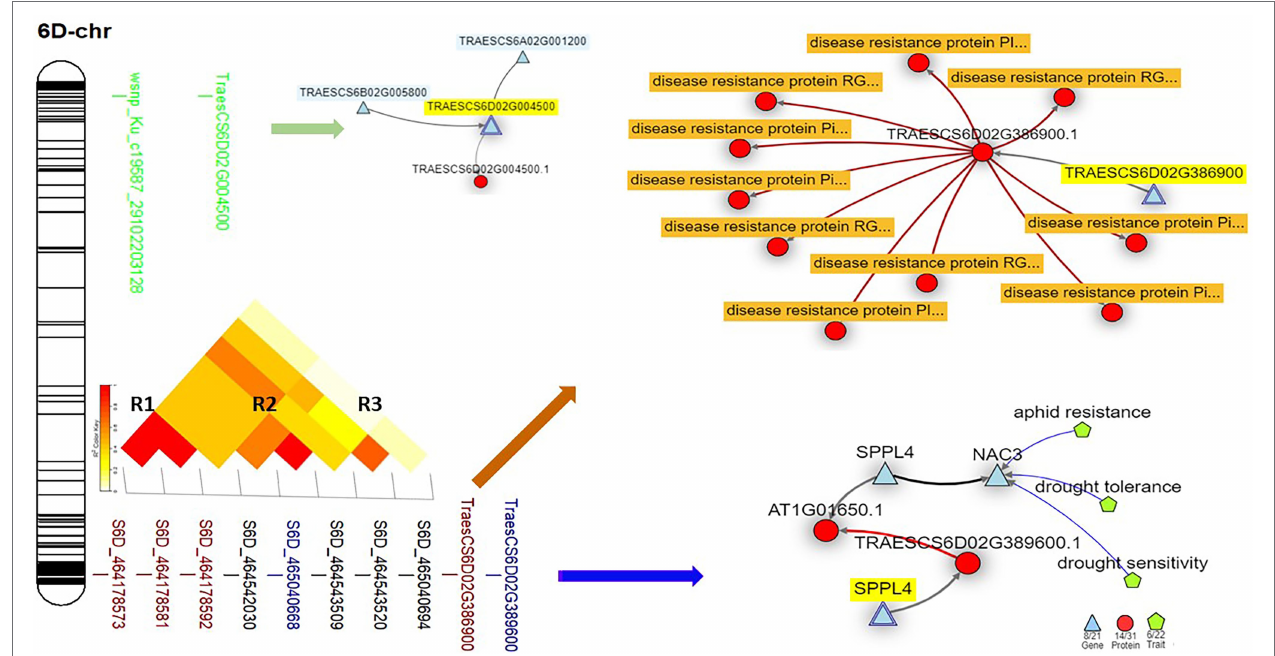
FIGURE 6 | The linkage disequilibrium between each pair of the significant markers identified on 6D chromosome, the gene model they are harboring, and the gene network of the identified gene models in related to disease